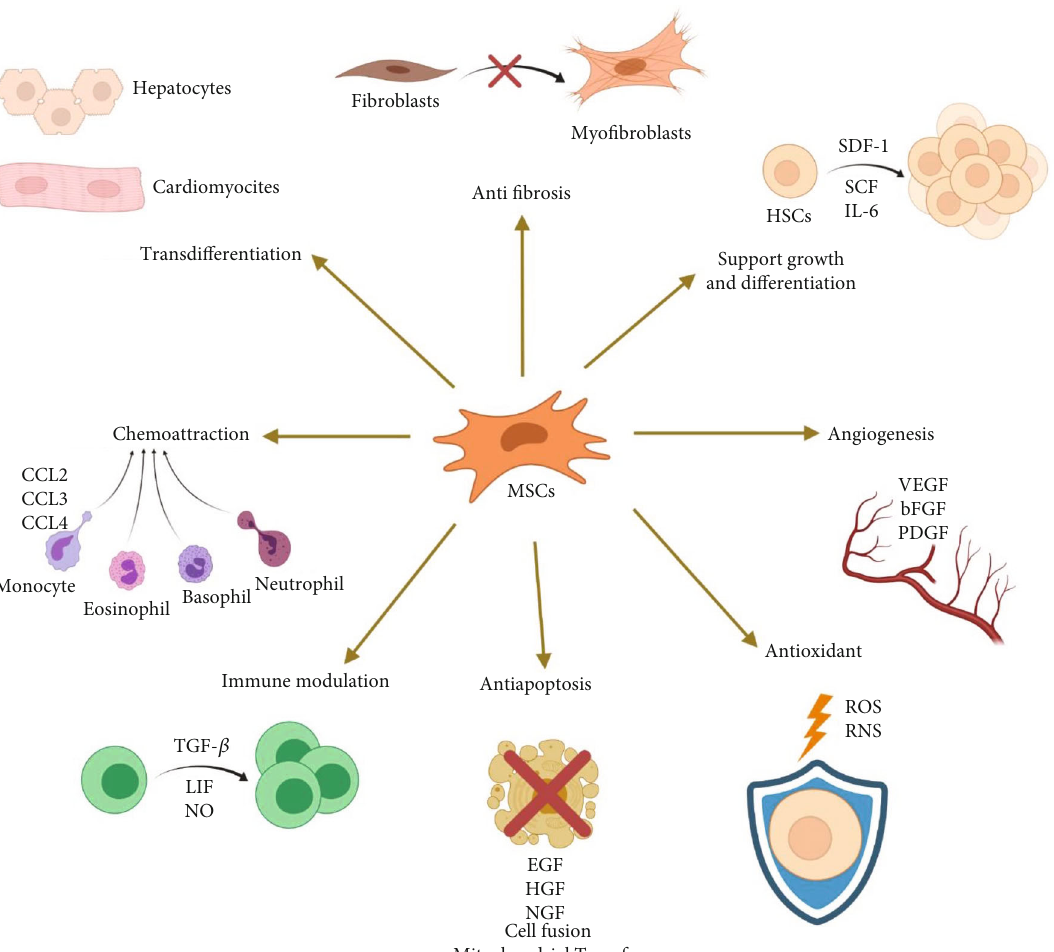
Figure 2: Mechanism of action of MSCs in tissue repair and immunomodulation. MSCs exert its therapeutic e ff ects via various modulators. SDF-1: stromal cell-derived factor 1; SCF: stem cell factor; IL-6: interleukin-6; VEGF: vascular endothelial growth factor; bFGF: basic fi broblast growth factor; PDGF: platelet-derived growth factor; ROS: reactive oxygen species; RNS: reactive nitrogen species; EGF: epidermal growth factor; HGF: hepatocyte growth factor; NGF: nerve growth factor; TGF- β : transforming growth factor-beta; LIF: leukemia inhibitory factor; NO: nitric oxide; CCL: C-C motif chemokine ligand (created with